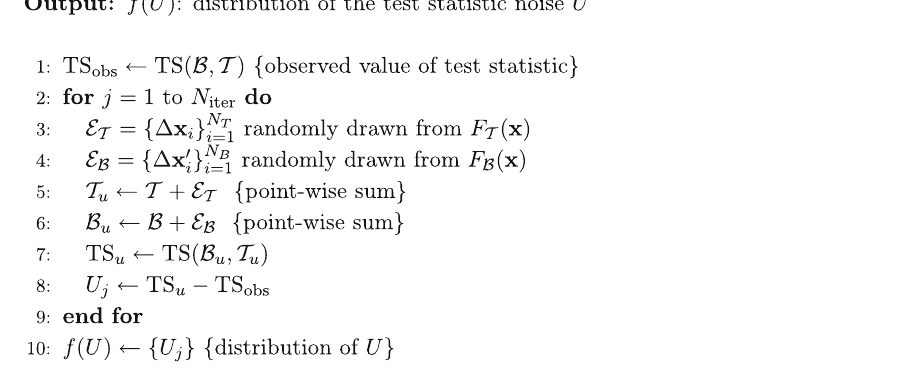
Table 2 Pseudo-code for the algorithm to find the distribution f ( U ) of the test statistic noise U